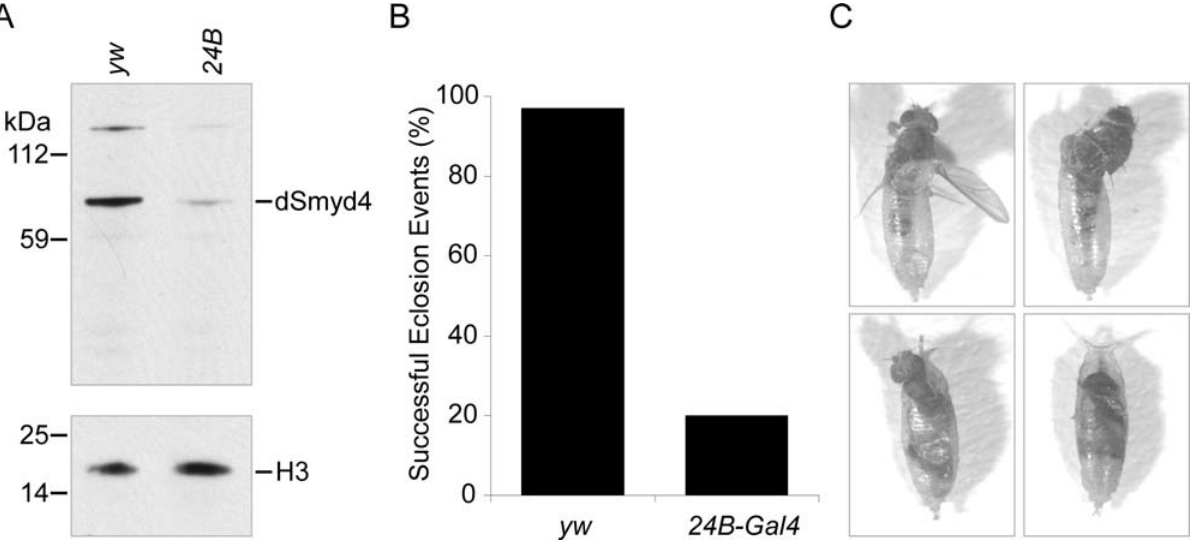
Figure 5. RNAi knockdown of dSmyd4 causes eclosion failure. A, Protein extracts prepared from adult flies were western blotted with anti- dSmyd4 and anti-histone H3 (H3). Flies in which RNAi was induced in the mesoderm ( 24B ) from CG14122R-3 expressed much lower levels of dSmyd4 compared to flies from control crosses ( yw ). B, Flies in which RNAi was induced in the mesoderm ( 24B-Gal4 ) showed impaired ability to eclose from the pupal case compared to flies from control crosses ( yw ). n=171 for both crosses. C, Photographs of CG14122R-3 / 24B-Gal4 flies that remained trapped in the pupal case and died during various stages of eclosion.